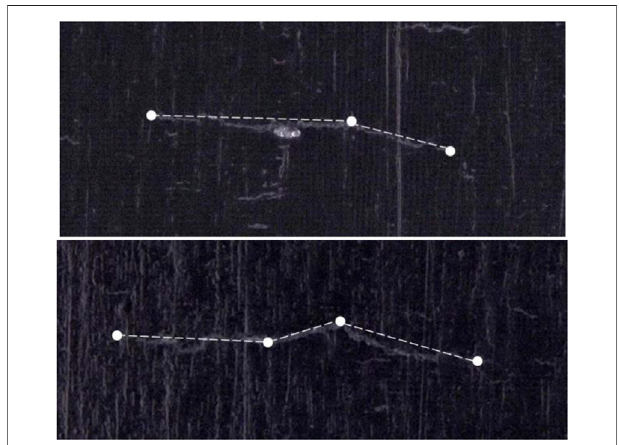
FIGURE 2 | Examples of idealized kinked crack con fi gurations overlaid on surface replication images. (A) a crack with two segments and a single kink, (B) a crack with three segments and two